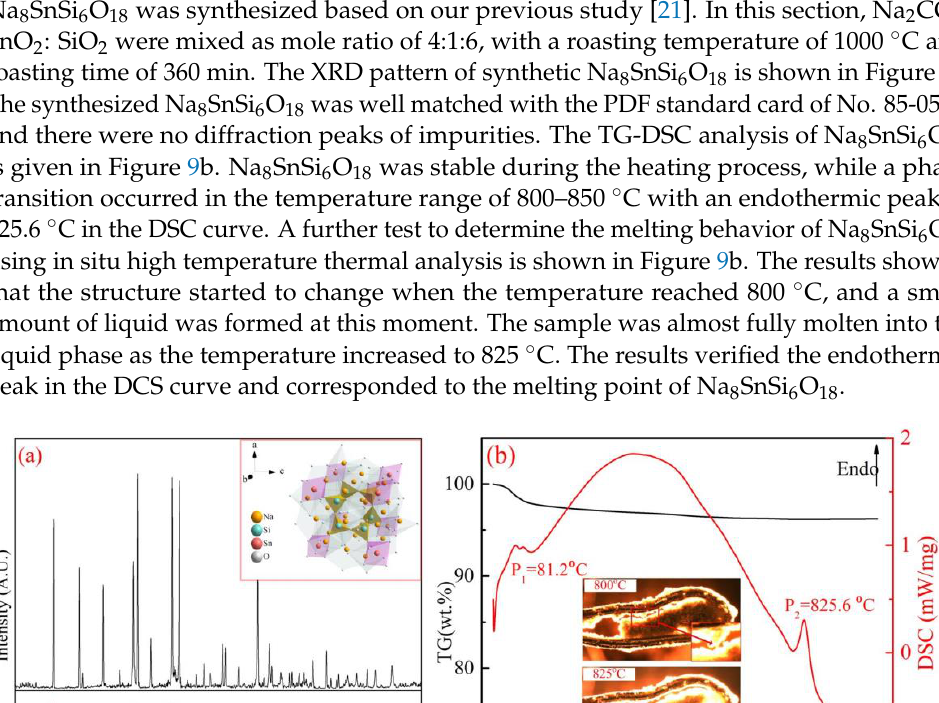
Figure 10. Reactions between Na 8 SnSi 6 O 18 and Na 2 CO 3 (( a )-TG-DSC analysis, ( b )-XRD analysis of the TG